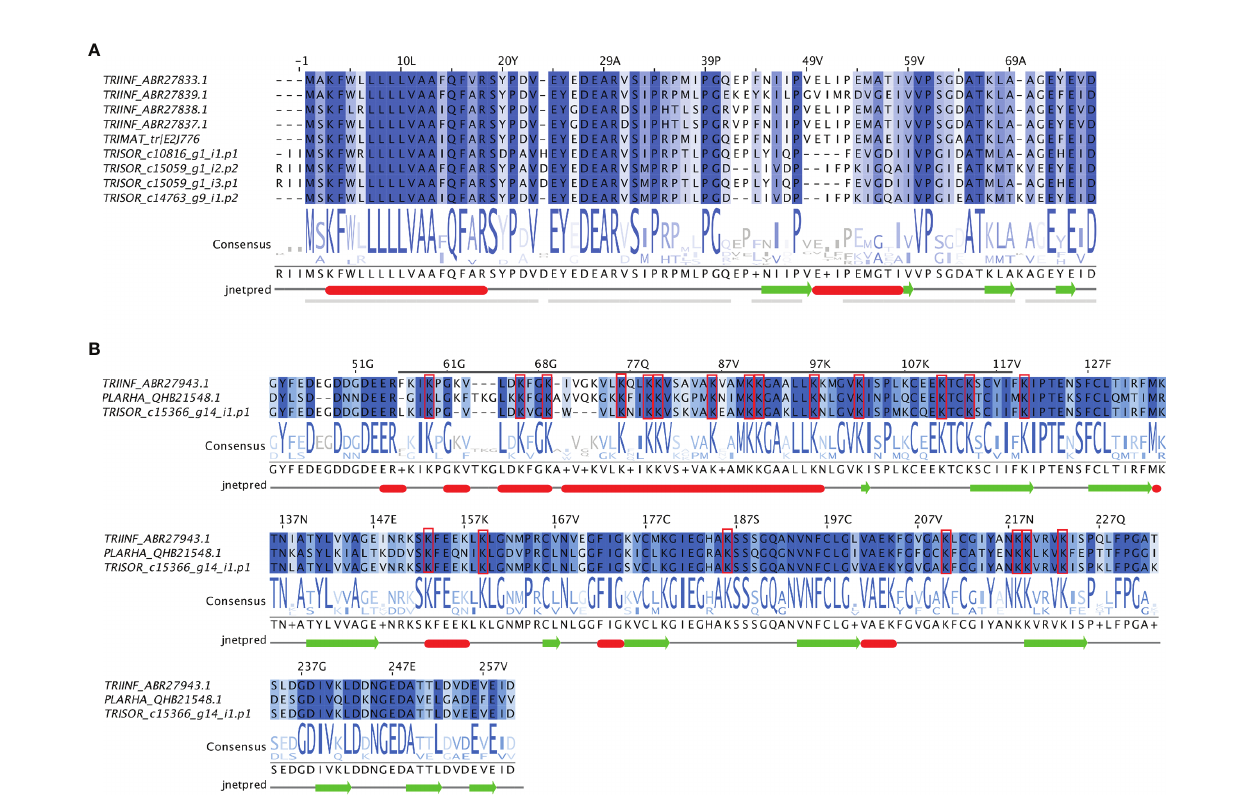
FIGURE 3 | The trialysins from Triatoma sordida sialotranscriptome. (A) Multiple sequence alignment of short-trialysin members extracted from T. sordida sialotranscriptome (TRISOR_c10816_g1_i1.p1; TRISOR_c15059_g1_i2.p2; TRISOR_c15059_g1_i3.p1; TRISOR_c14763_g9_i1.p2) and other homologous short- trialysin sequences from Triatoma infestans (TRIINF_ABR27833.1; TRIINF_ABR27839.1; TRIINF_ABR27838.1; TRIINF_ABR27837.1) and Triatoma matogrossensis (TRIMAT_tr/E2J776) (B) Multiple sequence alignment of a r-trialysin member extracted from T. sordida sialotranscriptome (TRISOR-c15366_g14_i1.p1) and two homologous members, a r-trialyisn from Triatoma infestans (TRIINF_ABR27943.1) and a redulysin from P. rhadamanthus (PLARHA_QHB21548.1). The sequences are identi fi ed as described in Methods section. The alignments indicate conserved residues in a blue scale background. The grey bar marks the consensus motif of trialysins, red rectangles mark Lys residues. Consensus logo sequence shows the frequency of amino acids in the multiple sequence alignment. The height of symbols within the stack indicates the relative frequency of each amino acid at that position. Secondary structure predictions were inferred using JNet Secondary Structure Prediction. The sequence for which the prediction was made is the fi rst one in the